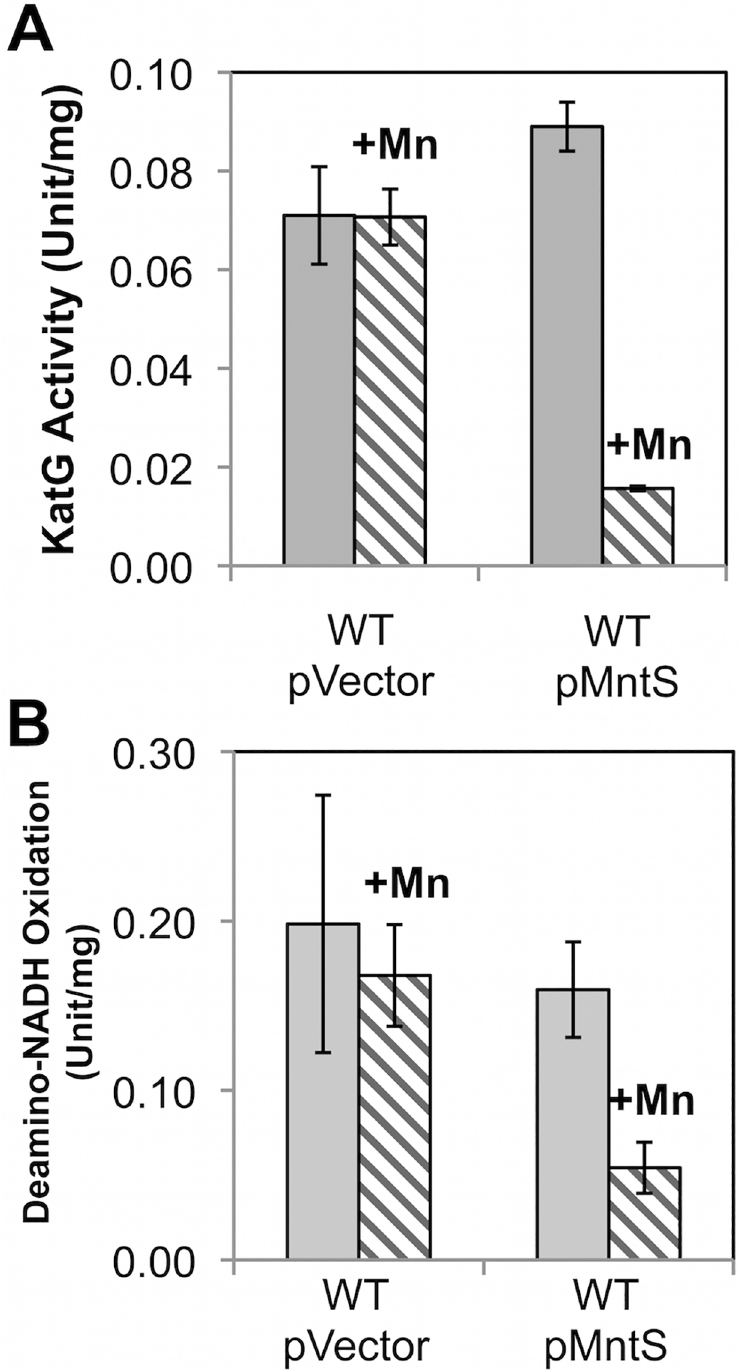
Fig 7. Heme-containing enzymes, catalase and cytochrome oxidase, fail to function properly during manganese toxicity. Cells were grown in anaerobic LB/arabinose medium with or without 0.5 mM MnCl 2 and aerated for 2.5 hr before harvesting. Data represent the mean of three independent cultures. A. KatG activity was determined from strains JEM1405 (WT/pBAD24) and JEM1406 (WT/pLW112). B. Deamino- NADH oxidation was determined from JEM1397 (WT/pBAD24) and JEM1398 (WT/pLW112). These strains lack the back-up iron-sulfur suf operon in order to demonstrate that the failure of heme synthesis was not accompanied by defects in iron-sulfur assembly by the Isc system (S4A